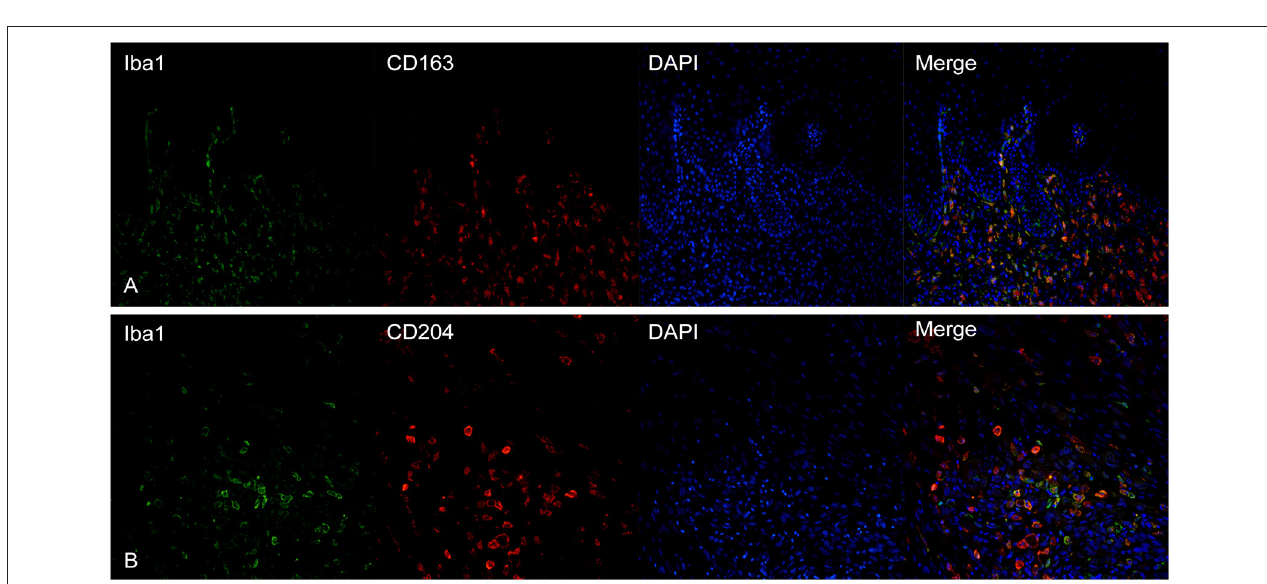
FIGURE 4 | (A) Canine, oral melanoma. Colocalization of Iba1 (green) and CD163 (red) shows a partial co-expression of the two markers. Intraepithelial dendritic cells are negative for CD163 but positive for Iba1. (B) Canine, oral melanoma. A partial overlap of Iba1 (green) and CD204 (red) was observed. Nuclear counterstain was performed with